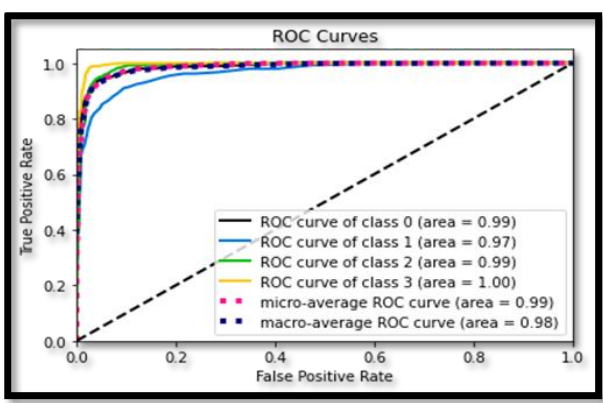
Fig. 13 . ROC Curve for apple